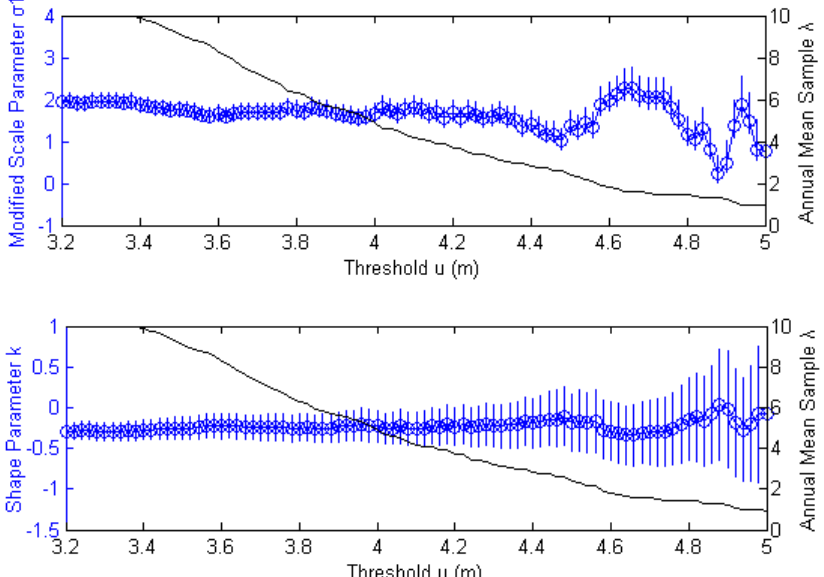
Figure 6. The modified scale parameter ( above ) and shape parameter ( below ) in relation to the thresholds (3.2–5.0 m) at location S1.